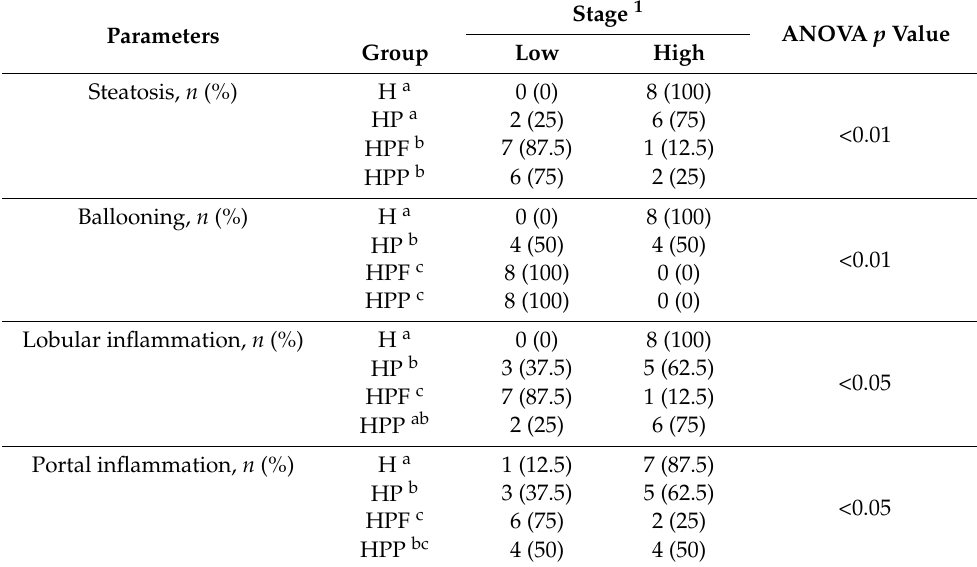
Figure 2. Inflammatory cytokines in the plasma of rats fed the experimental diets. The values are the means ± SEMs. a,b Mean values not sharing the same superscript letter (a or b) are different at p < 0.05 in a post hoc test (Dunn’s test). * Mean values are significantly different in comparison to the control H group, fed a high-fat diet. HP, control high-fat diet enriched with raspberry polyphenol extract; HPF, control high-fat diet enriched with raspberry polyphenol extract and fructo-oligosaccharides; HPP, control high-fat diet enriched with raspberry polyphenol extract and pectin. TNF α , tumour necrosis factor α ; IL-6, interleukin 6; IL-10, interleukin 10. Table 5. Liver histological characteristics of rats fed the experimental